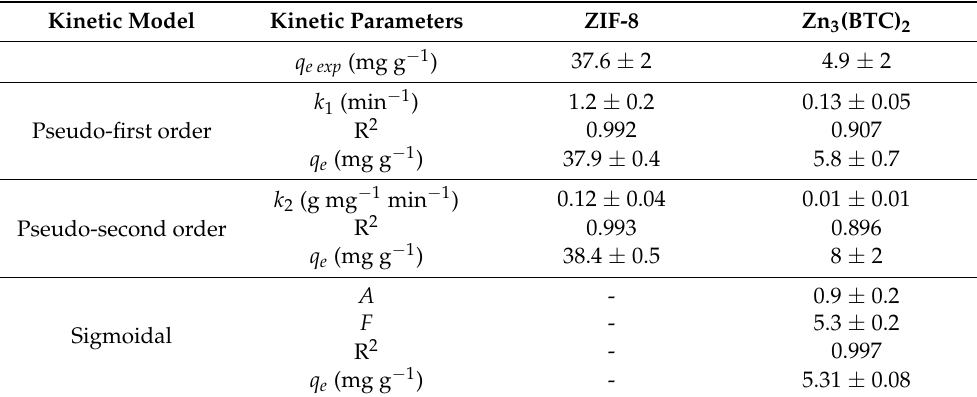
Table 2. Kinetic parameters were obtained by fitting the experimental data for OFL adsorption on ZIF-8 and Zn 3 (BTC) 2